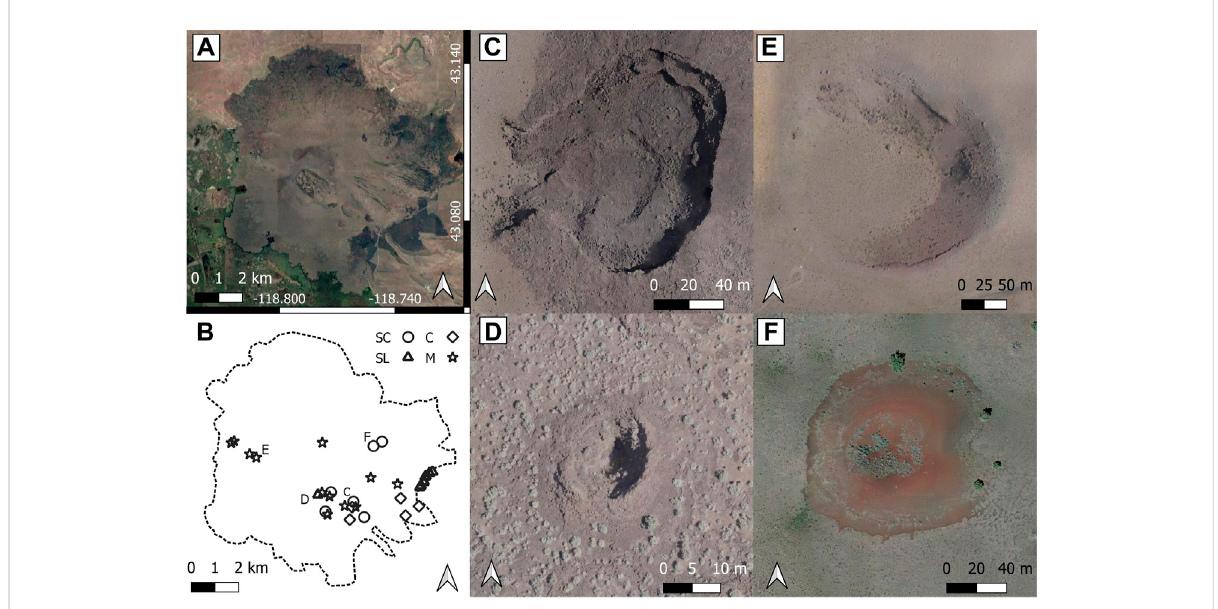
FIGURE 1 Monogenetic volcanic fi elds can have maars, scoria cones, spatter landforms, and lava collapse features. (A) Diamond Craters in Oregon, USA (DCOR) is a basaltic monogenetic volcanic fi eld in SE Oregon with an approximate area of 70 km 2 . (B) Location of maars (M), lava collapse features (C) , scoria cones (SC), spatter landforms (SL), and other monogenetic volcanic landforms. (C) Keyhole Crater, DCOR, a lava collapse feature. (D) DC0029,DCOR,acircularspatterlandform,commonlyreferredtoasaspattercone. (E) EastTwinMaar,DCOR. (F)